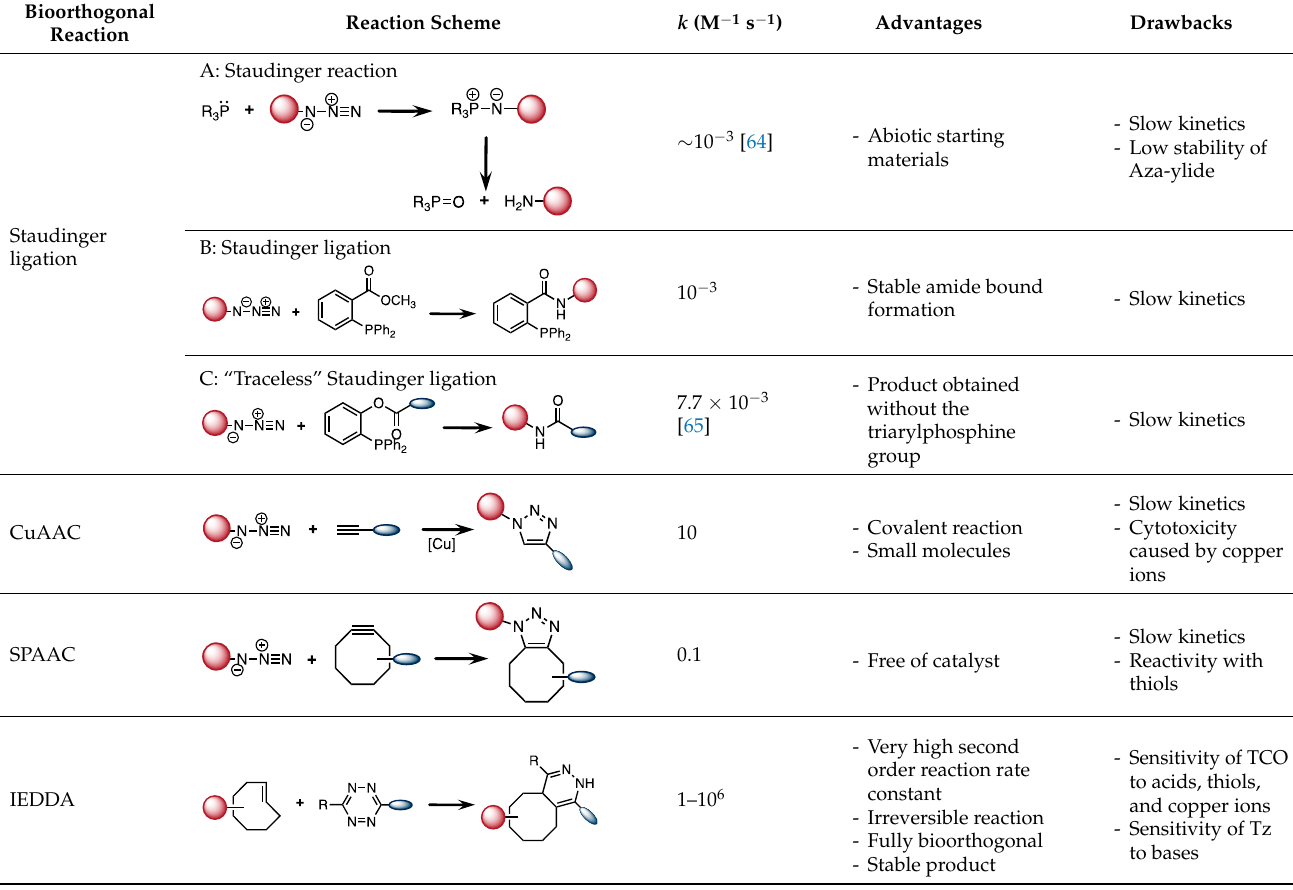
Table 1. Chemical characteristics of the bioorthogonal reactions covered in this review. Bioorthogonal Reaction Scheme Drawbacks